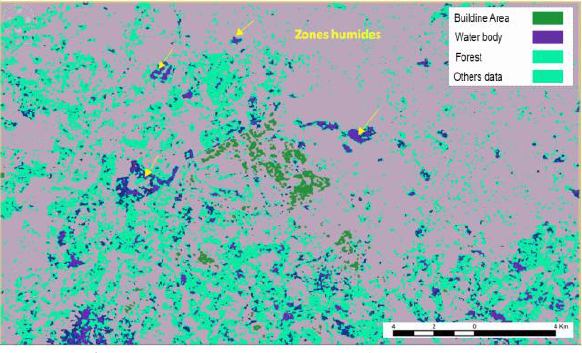
Figure 8. Random Forest classification results ➢ Classification of the temporal series image with the algorithm